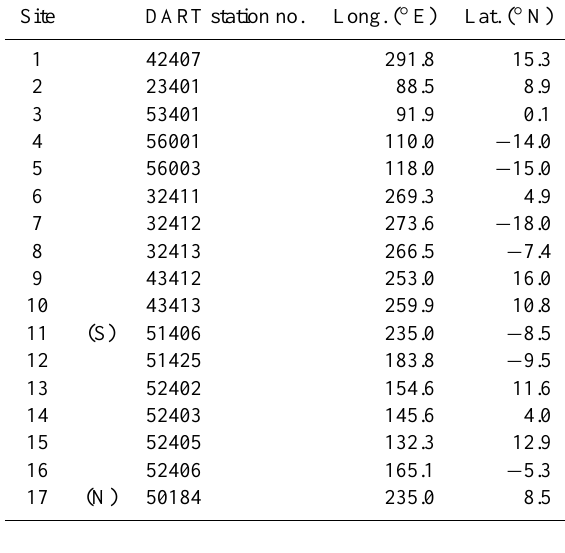
Table A1. Locations of the bottom-pressure sensors used in this study.